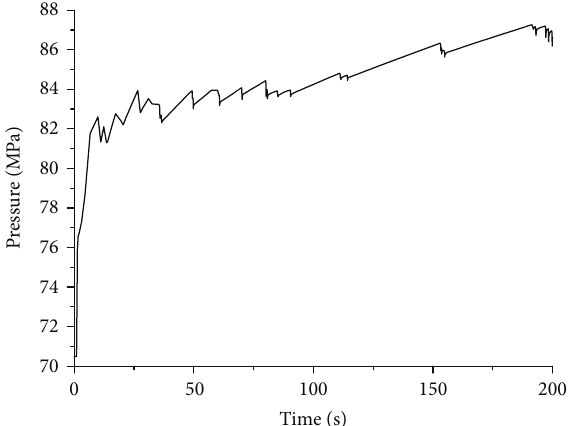
Figure 38: Pressure curve at the NF approaching angle of 60 ° and under a stress anisotropy coe ffi cient of